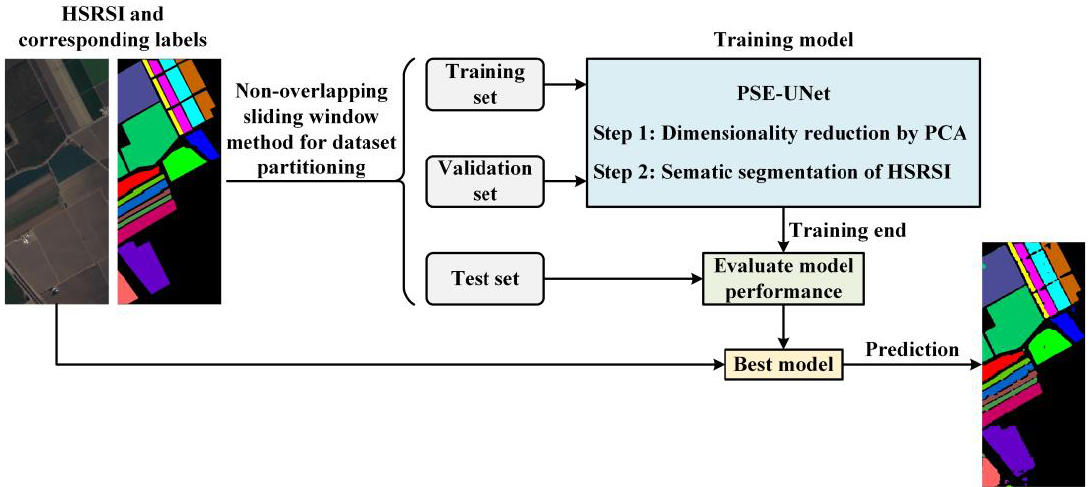
Figure 1. Flowchart of the proposed procedure.